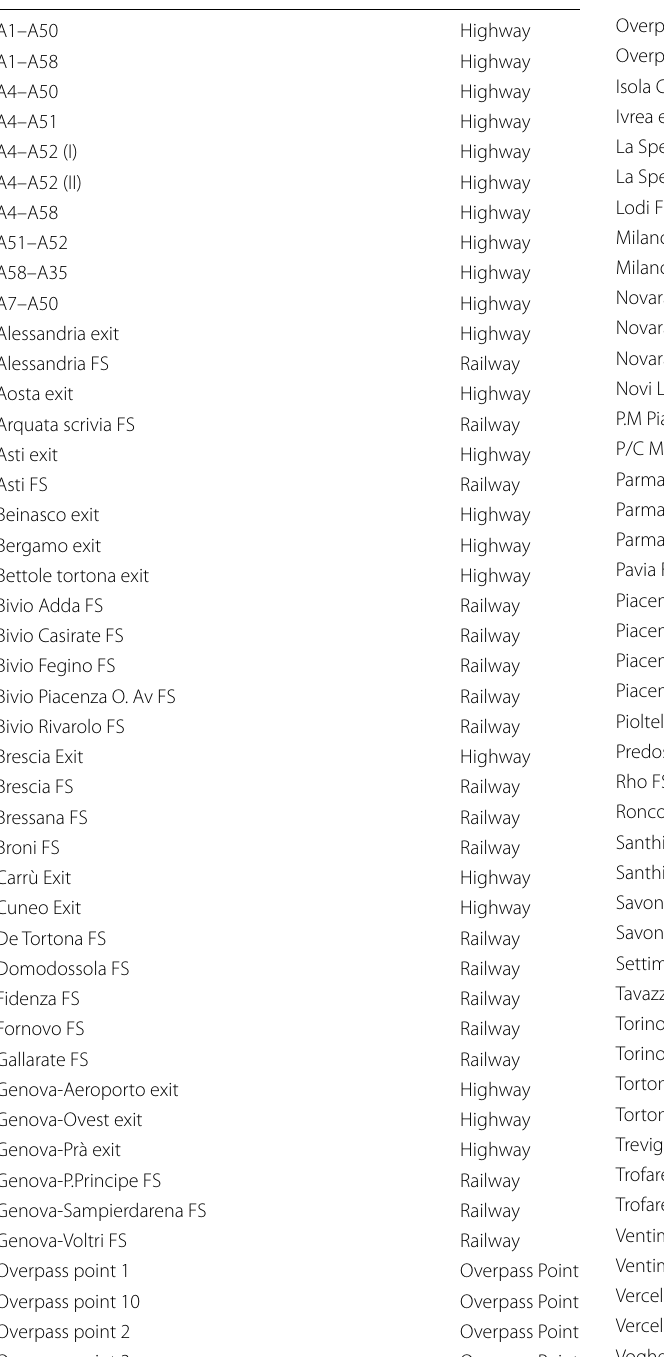
Table 4 Full list of nodes: motorway exits, railways station and overpass